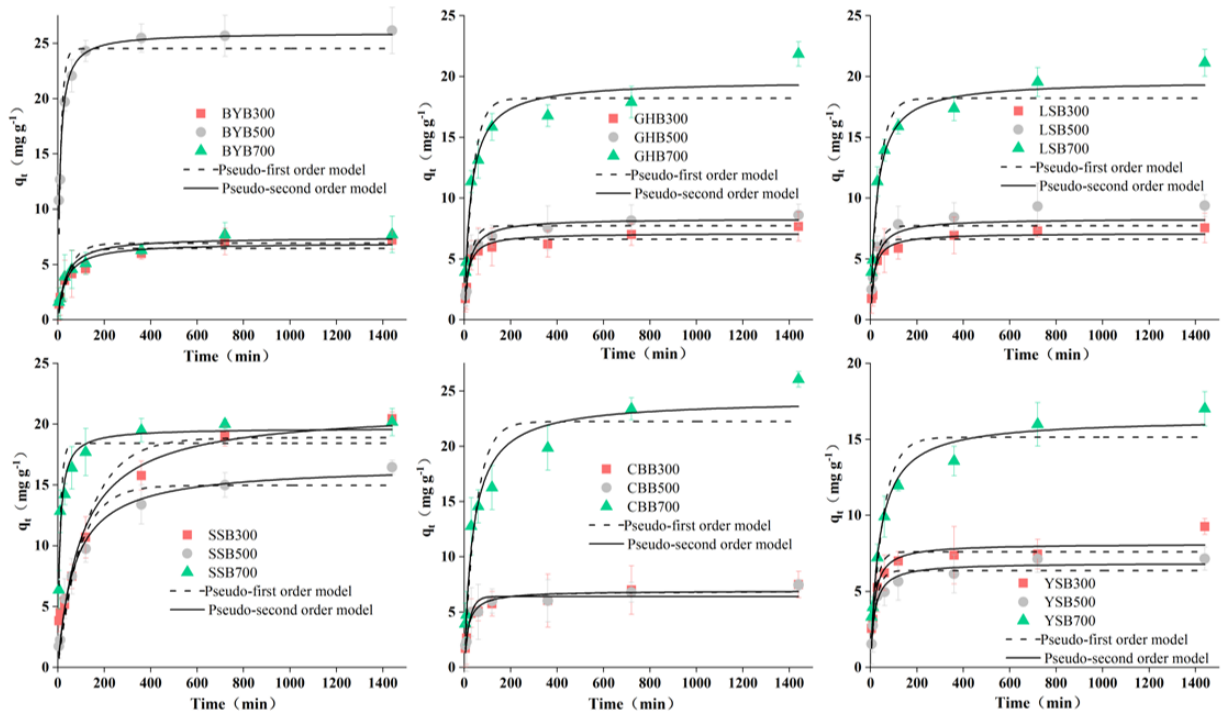
Figure 6. Kinetics fitting results of different biochar types (pH: 2.0; dosage of biochar: 1.2 g · L − 1 ; Cr (VI) concentration: 50 mg · L − 1 ).